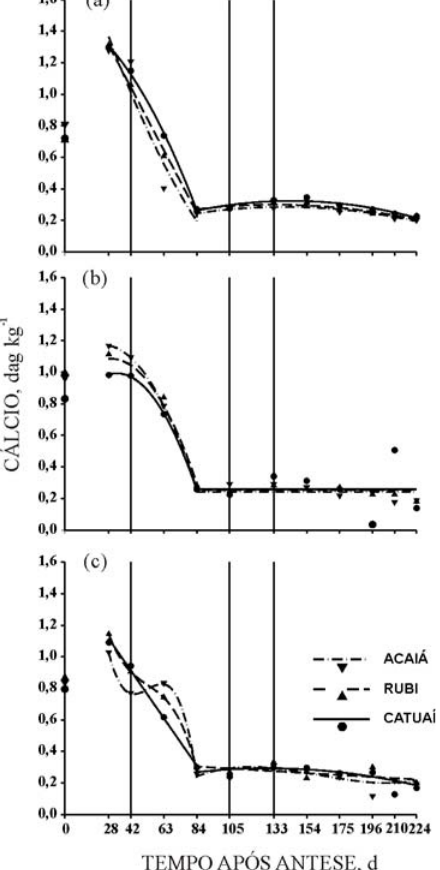
Figura 2. Concentração de cálcio em frutos de cafeeiro durante o período reprodutivo, nos níveis baixo (a), adequado (b) e alto (c) de adubação. As linhas verticais delimitam os estádios de desenvolvimento do fruto de chumbinho, expansão rápida, crescimento suspenso e